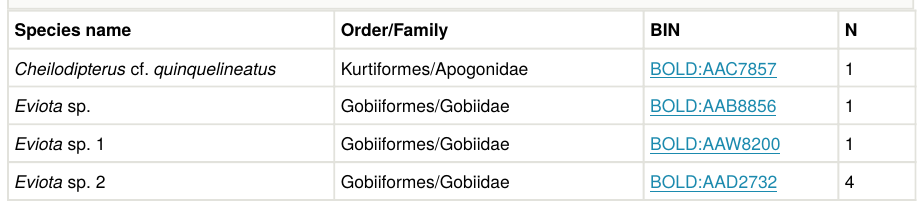
Species that could not be identi fi ed below genus